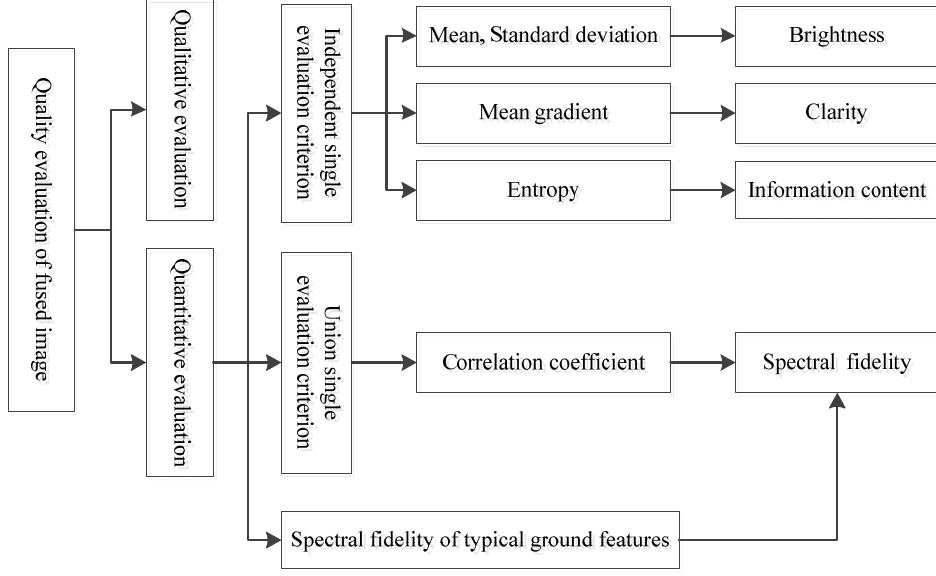
Figure 4. Structure of the fused image quality evaluation system. The gray mean value is primarily used to describe the average brightness of the